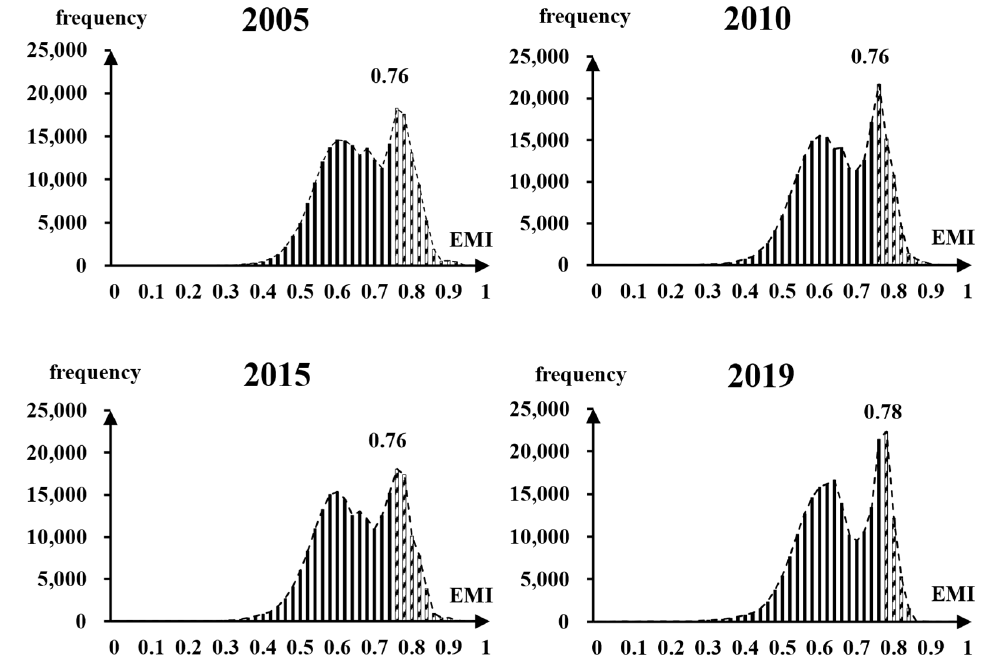
Figure 4. Frequency distribution histogram and extraction threshold of ECI.